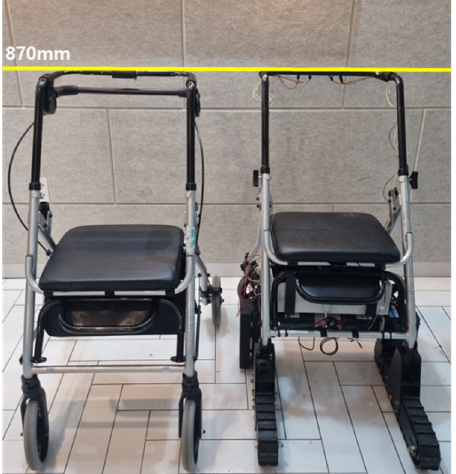
Figure 6. The general-type walker and caterpillar-type walker used in the experiment.